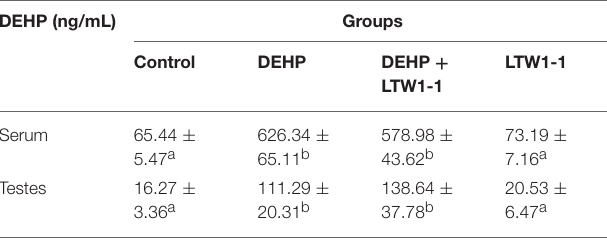
TABLE 1 | DEHP concentrations in serum and testes in different groups at the end of